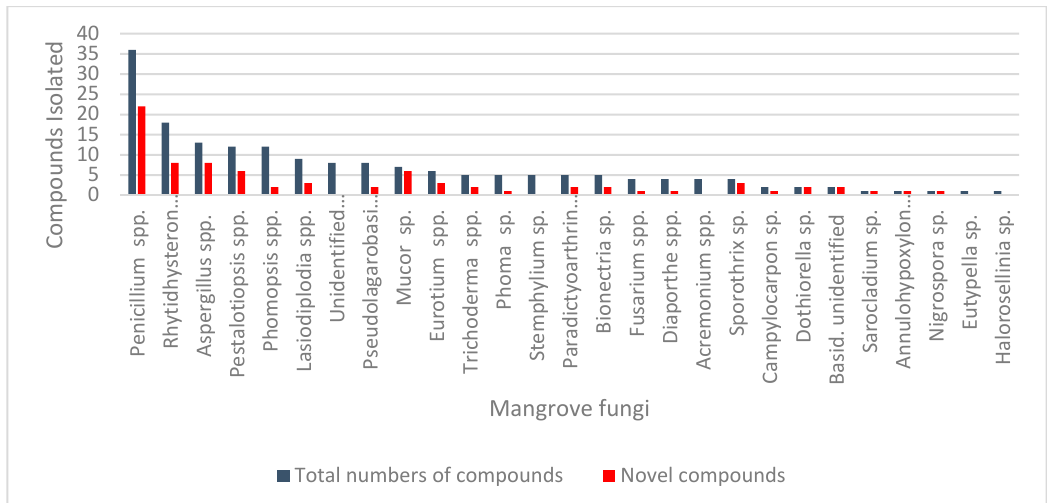
Figure 1. Novel anticancer bioactive compounds reported from mangrove fungi.